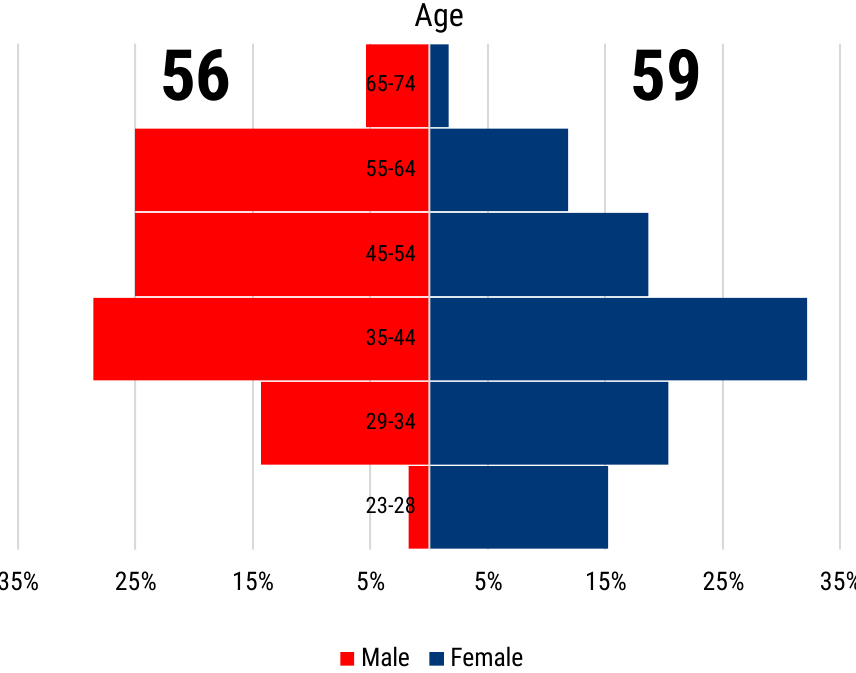
Figure 1. Population pyramid of participants, with 56 males (red) and 59 females (blue) grouped in six age ranges.